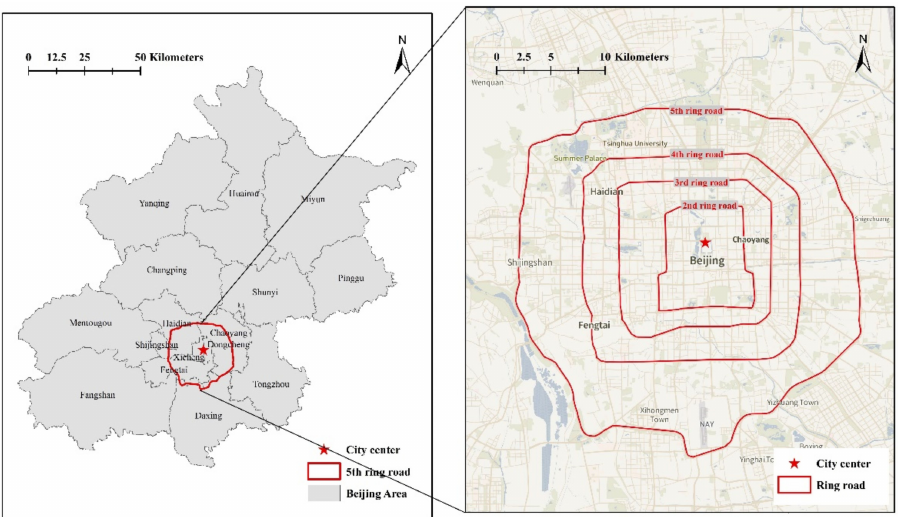
Figure 2. Map of the study area (fifth ring road) in Beijing, which covers the urban area of the